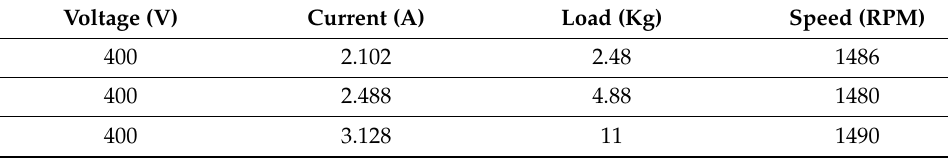
Table 6. Speed performance in balanced load condition.